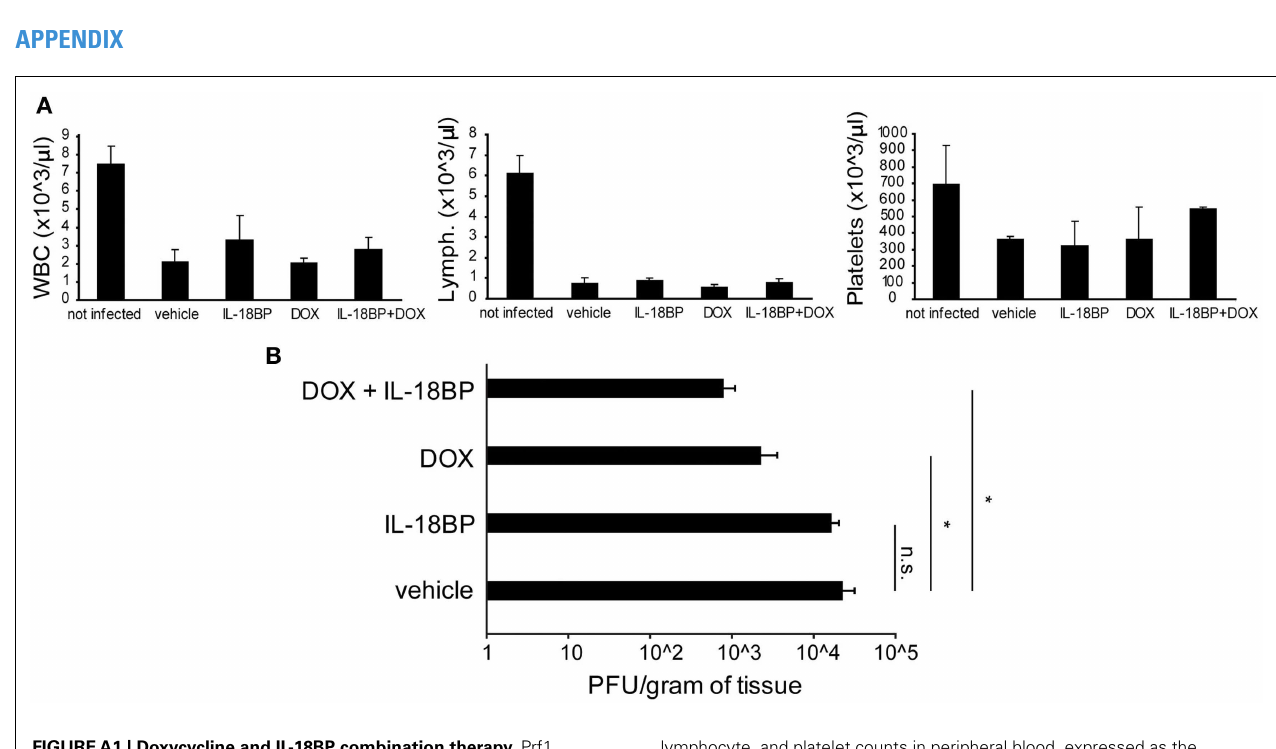
FIGUREA1 | Doxycycline and IL-18BP combination therapy. Prf1 KO mice were infected with DN-SCP-MCMV and treated with IL-18BP, DOX, or both. Six days after infection mice were sacrificed and different parameters were evaluated. (A) White blood cell,